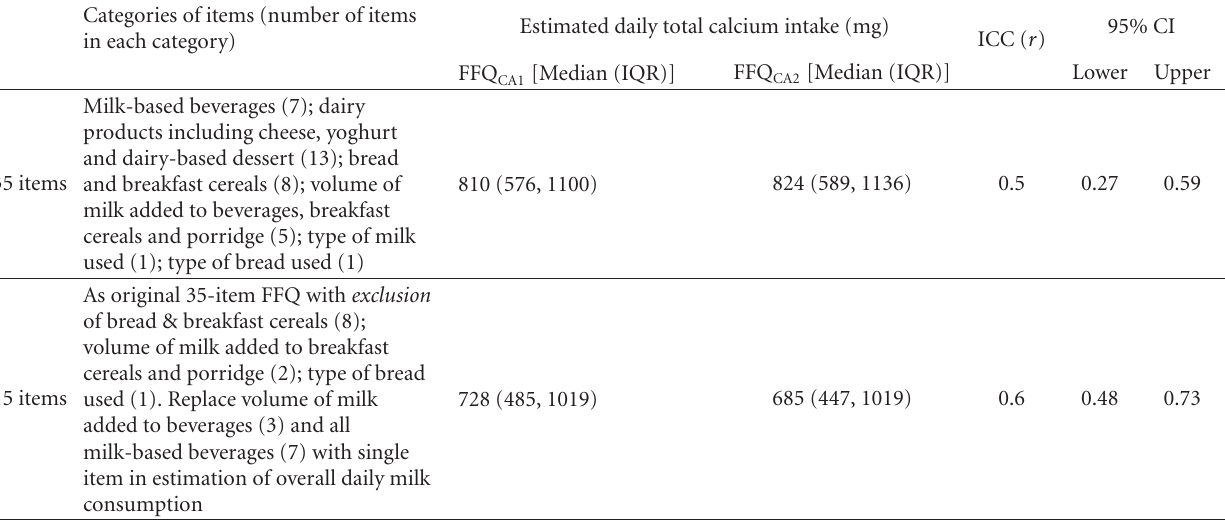
Table 2: Median (IQR) estimated daily total calcium intake, intraclass correlation coe ffi cients (ICC), and confidence interval (95% CI) of repeated administration of the 35-item and 15-item Flinders Calcium Food Frequency Questionnaire ( FFQ CA ) in study participants ( ≥ 65